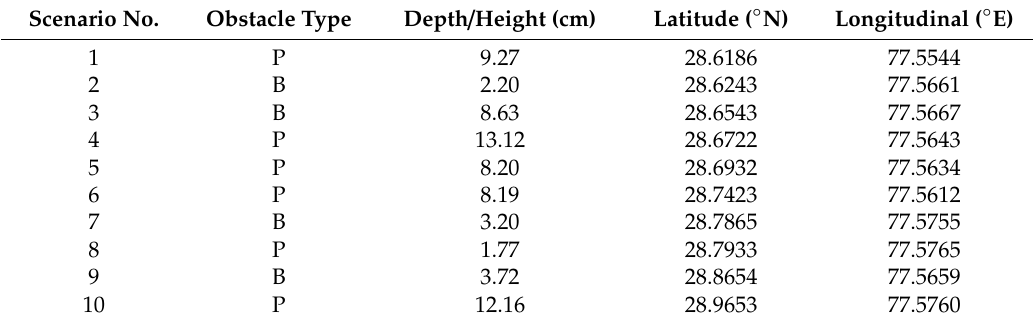
Table 4. Information of pothole (P) and bumps (B) collected during real-time testing using ultrasonic sensor with DTW for R2 test site Scenario No.